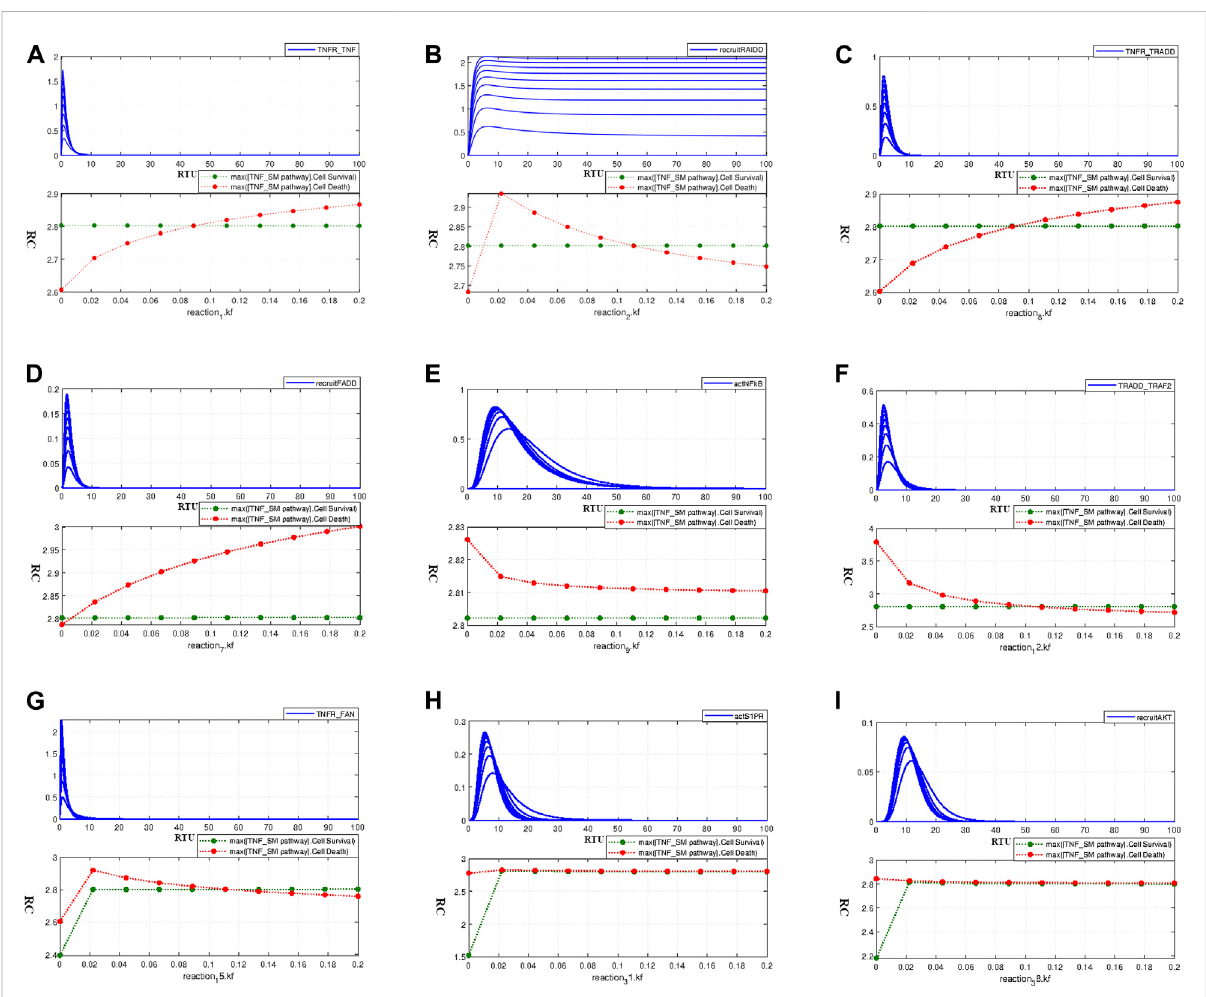
FIGURE 6 ParamaterScanningofTNF- α mediatedSphingolipidSignalingPathwaymodelinteractionswithknownkineticparametersfromtheliteratureto determine their tolerable range of variations and to study their effect on neuronal survival and death- (A) Paramater scanning for interaction 1 (Eq. 8) representing TNFR_TNF α formation. (B) Paramater scanning for interaction 2 (Eq. 9) representing recruitment of RAIDD. (C) Paramater scanning for interaction 8 (Eq. 10) representing formation of TNF_TRADD. (D) Paramater scanning for interaction 7 (Eq. 11) representing recruitment of FADD. (E) Paramater scanning for interaction 9 (Eq. 12) representing NF κ B activation. (F) Paramater scanning for interaction 12 (Eq. 13)